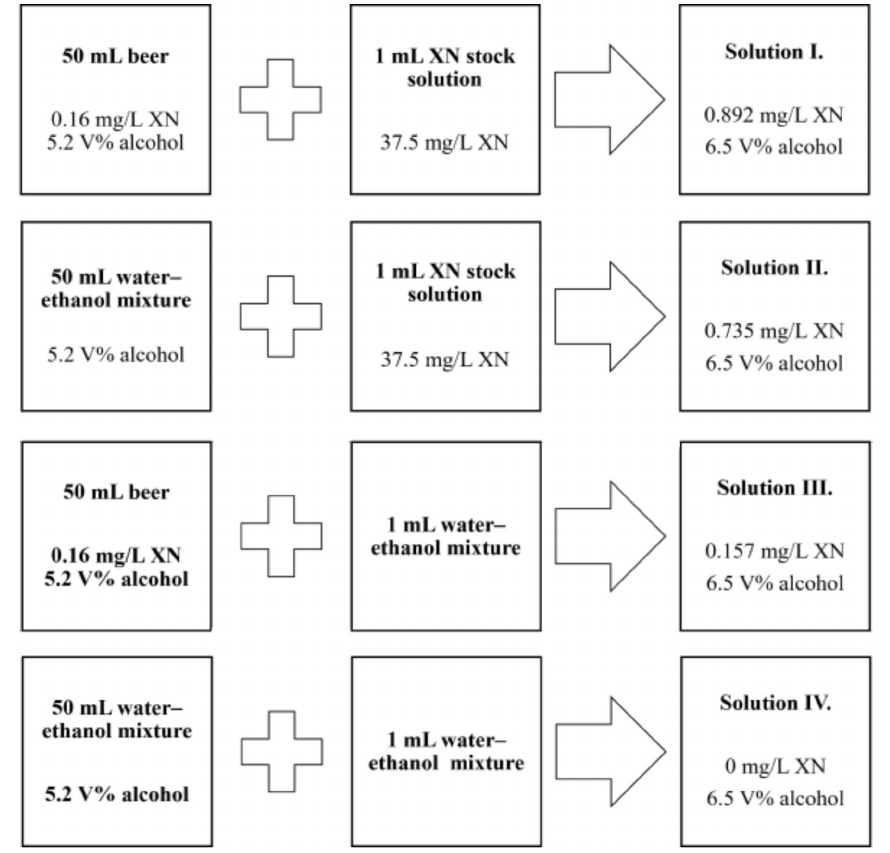
Figure 5. Preparation and characteristics of study